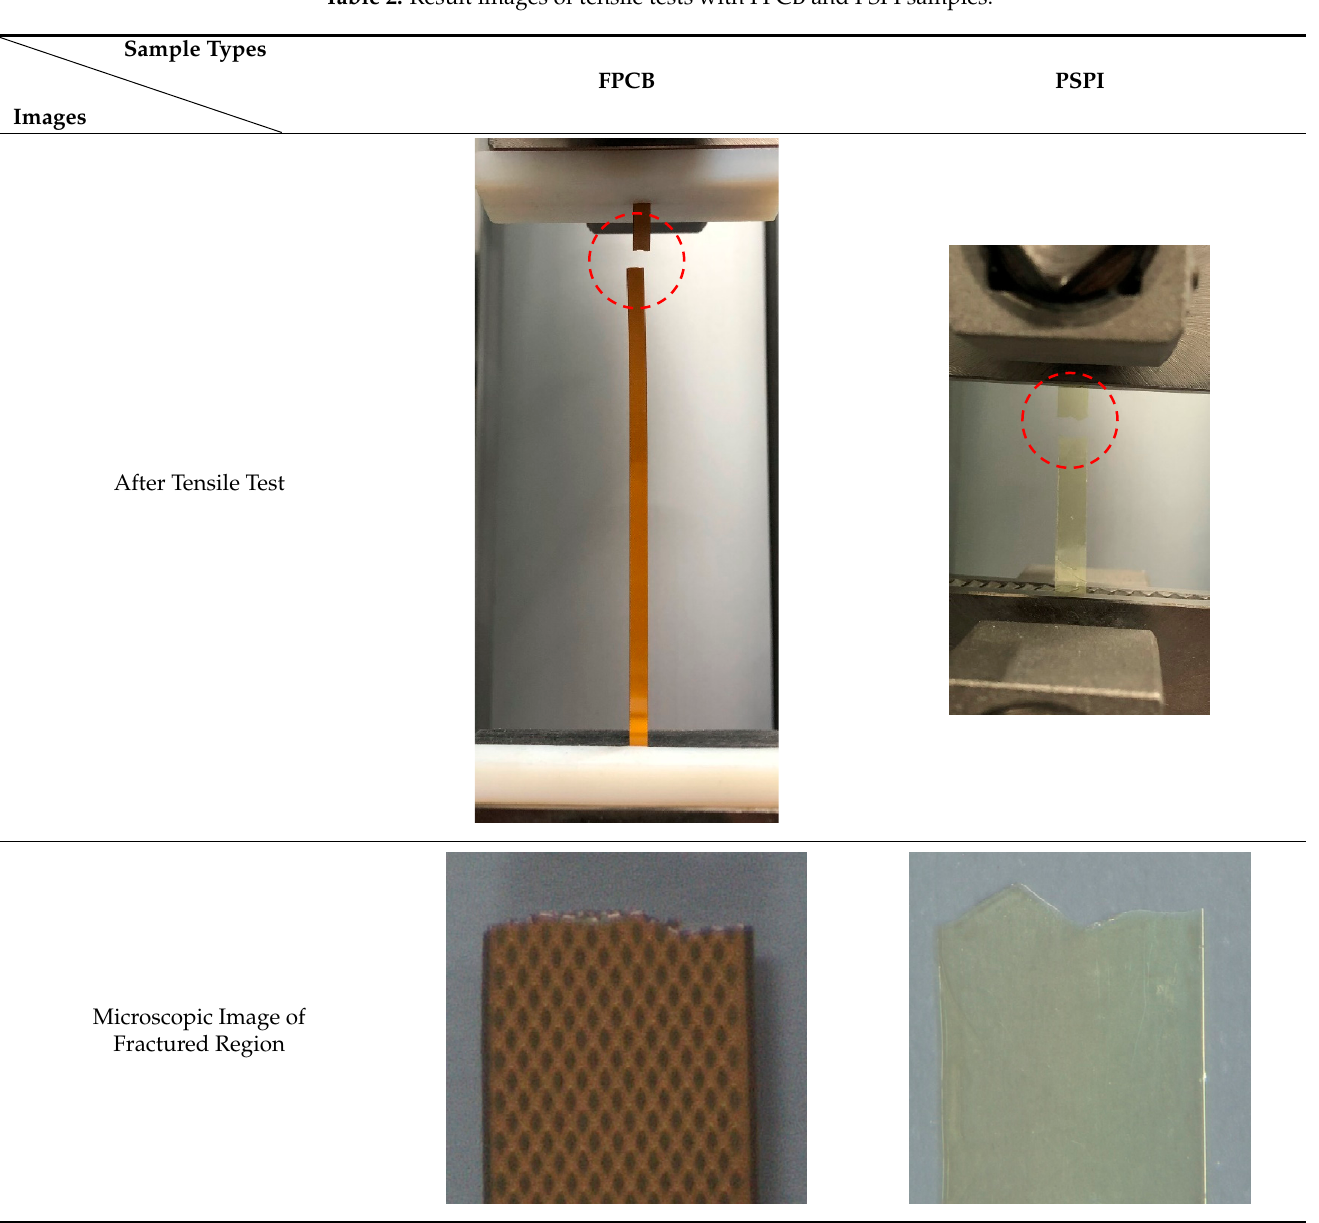
Table 1. Summary of FPCB and PSPI mechanical properties.